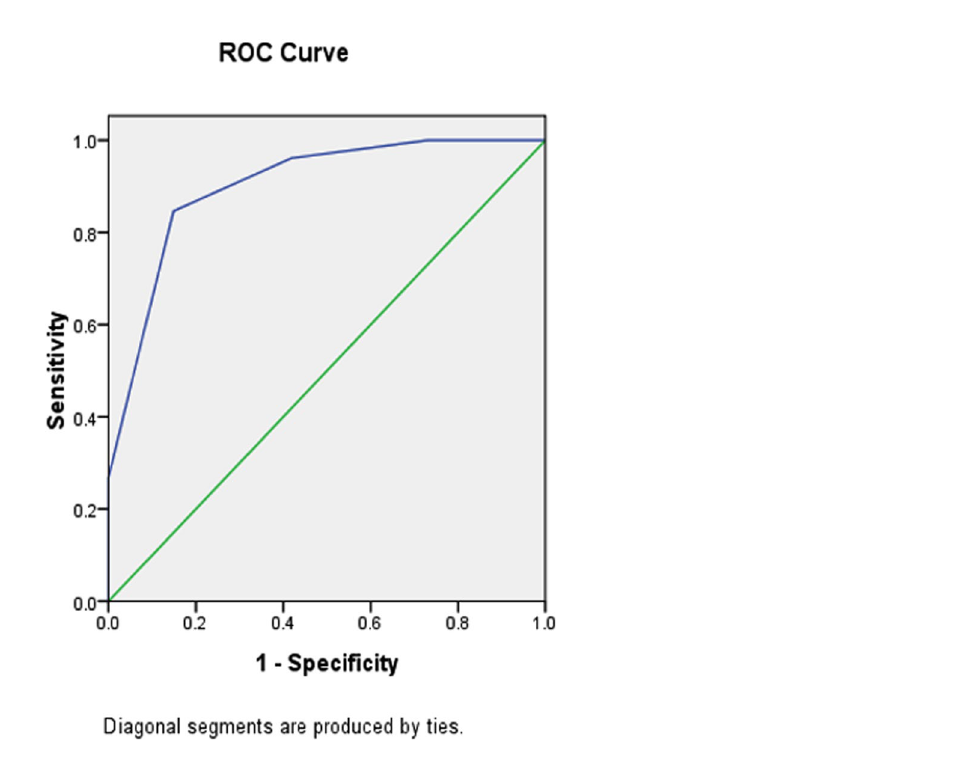
Figure 3. Receiver operating characteristics curves for MR diagnostic performance to differentiate PCC from non-PCC by means of statistical MR findings. The area under the curve was 0.902 ± 0.033; the sensitivity was 84.6%, and the specificity was